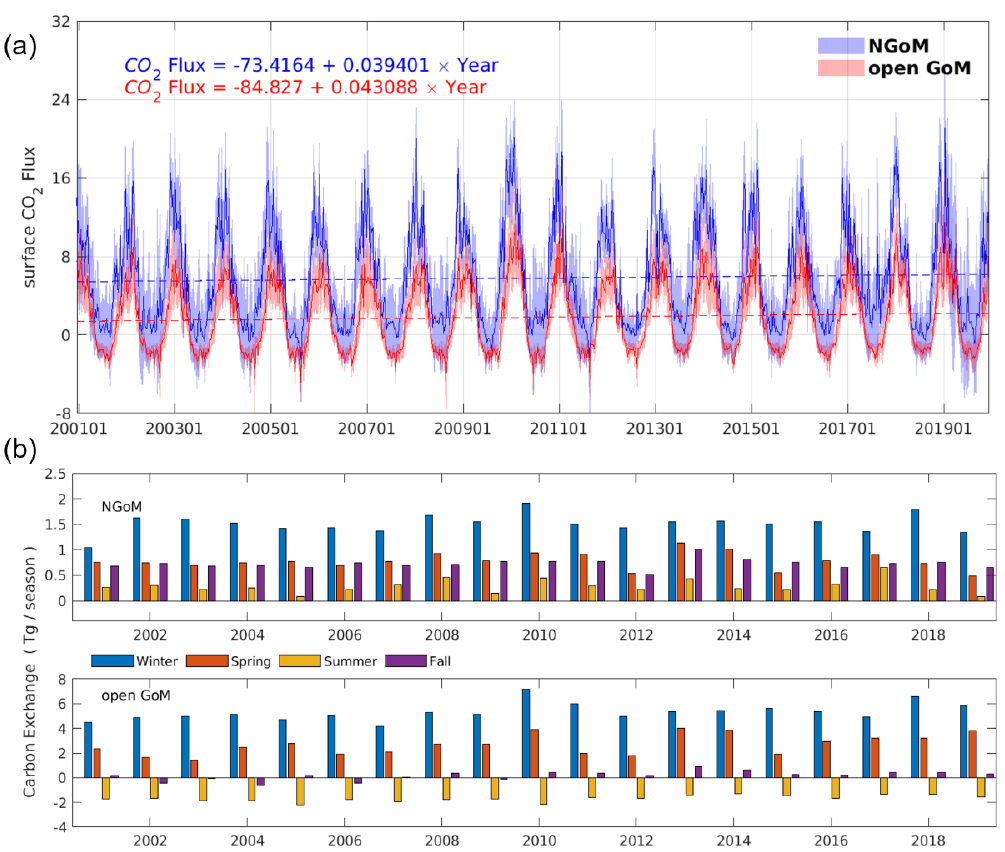
Figure 11. Air–sea CO 2 exchange over the GoM: (a) multiyear CO 2 flux regression over the weekly mean levels in NGoM and open GoM; (b) seasonal CO 2 air–sea exchange budget over 2 decades in NGoM and open